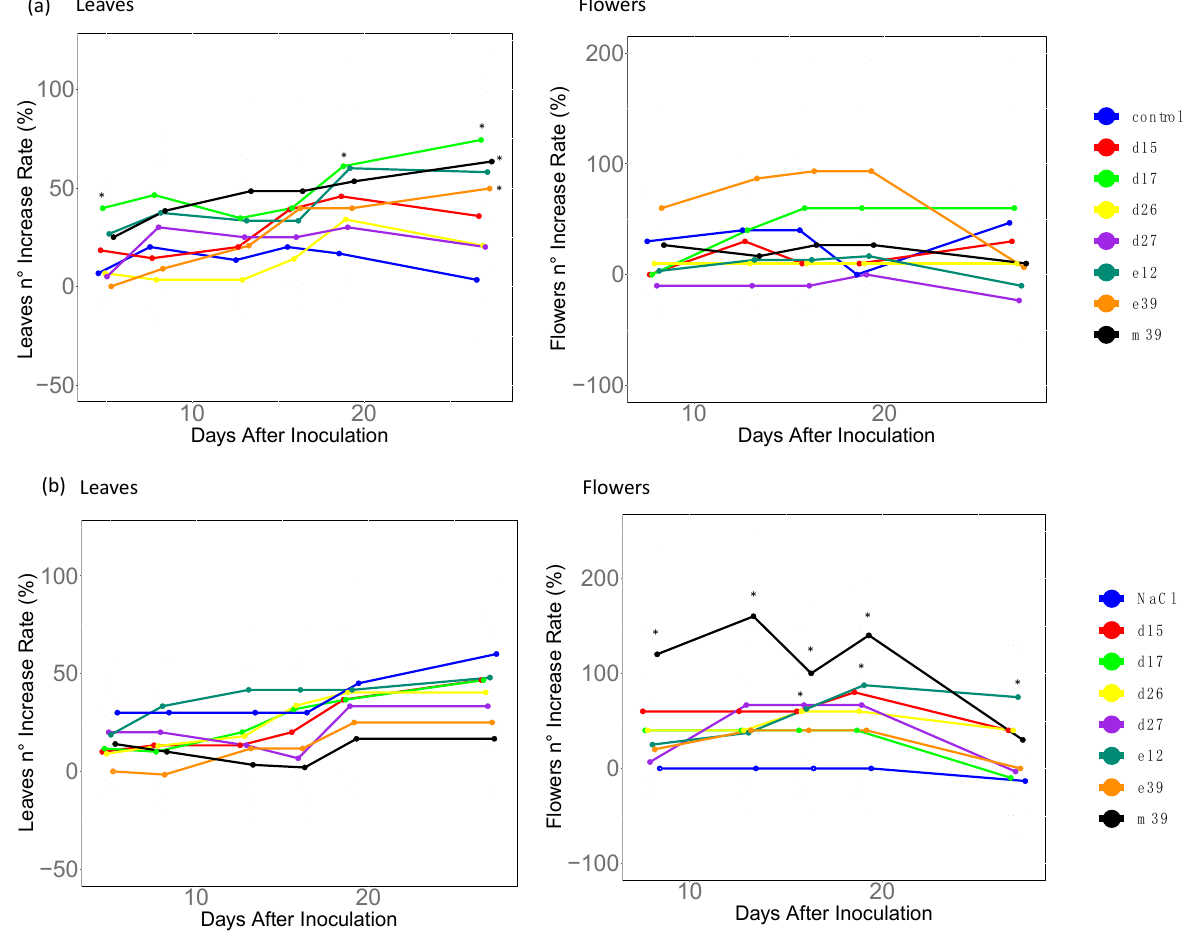
Figure 2. Leaf and flower growth rate of inoculated plants under no stress ( a ) or saline stress ( b ) conditions. Asterisks indicate parameters significantly different from the control, according to Student’s t -test at p -value < 0.05 ( n = 5).